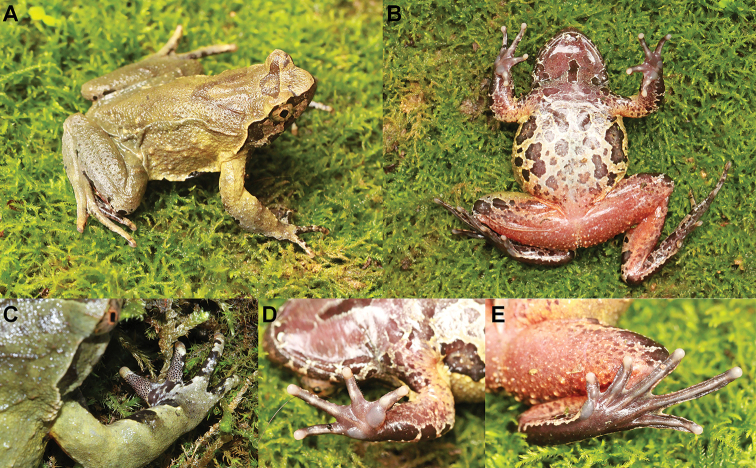
Photos of the holotype CIBTZ20190608017 of Megophrys
qianbeiensis sp. nov. in life A dorsal view B ventral view C dorsal view of hand D ventral view of hand E ventral view of foot.